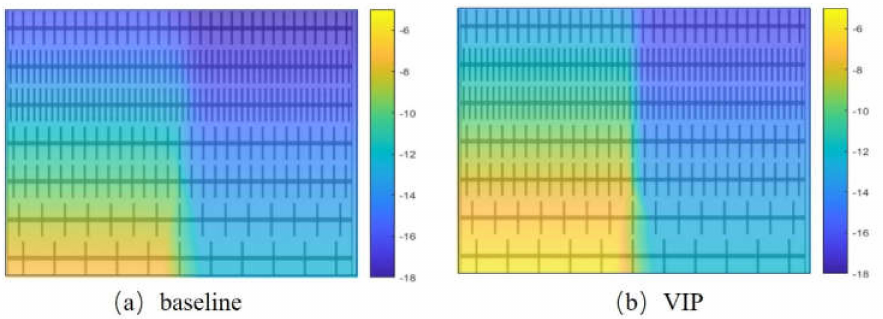
Figure 8. Simulated air temperature distribution at 20 min of the evaporator area in both cases: ( a ) baseline case; ( b ) VIP case. (VIP means vacuum insulation panel as defined in the text). Table 7. Average temperature of evaporator outlet air at 20 min in the simulation and experiment. Case Baseline VIP Experiment / ◦ C − 17.4 Simulation / ◦